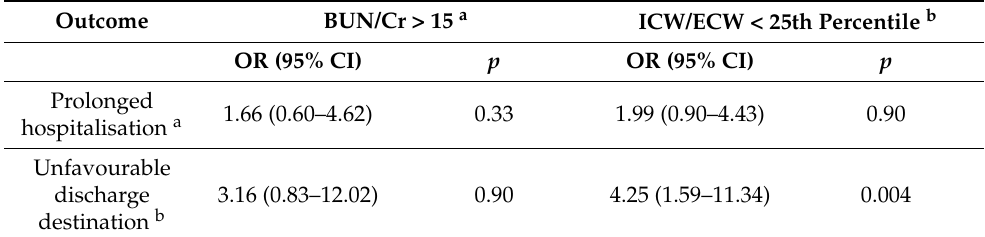
Table 3. Multivariable regression analyses showing relationship between measurements of hydration and outcomes of prolonged hospitalisation and poor discharge